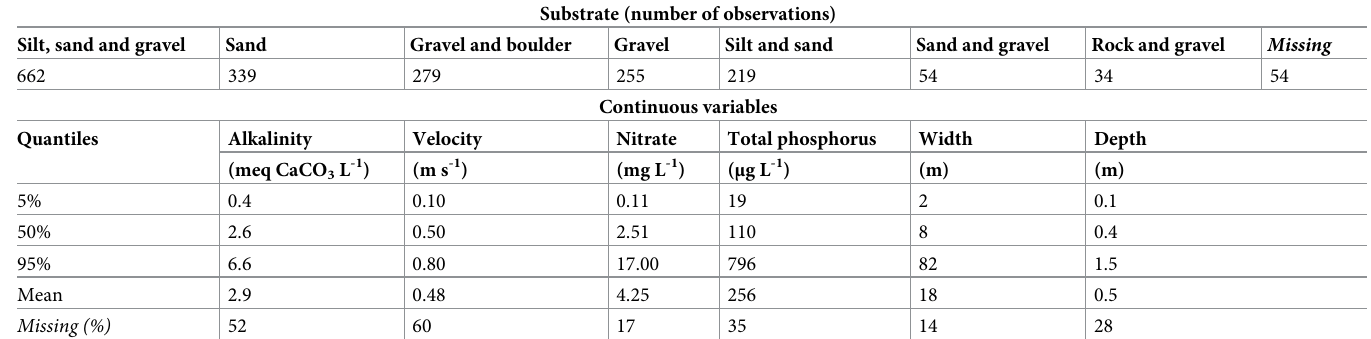
Table 1. Number of observations per category of the categorical variables (including missing values), and the quantiles (5, 50, 95%), mean and percentage of missing values of the continuous